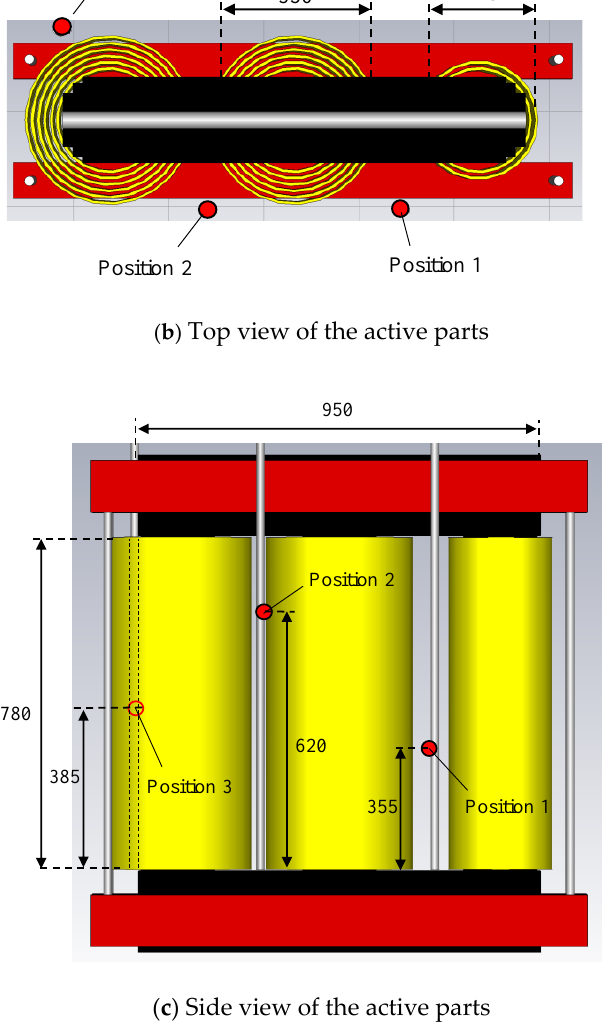
Figure 6. 3-D computational model of the transformer and positions of the three monopole antennas.